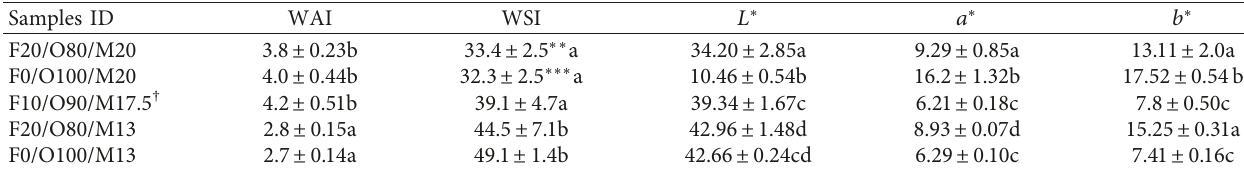
Table 2: Water solubility index, water absorption index, and color results of different mixtures of extruded collets from oca flour mixed with oat fiber.